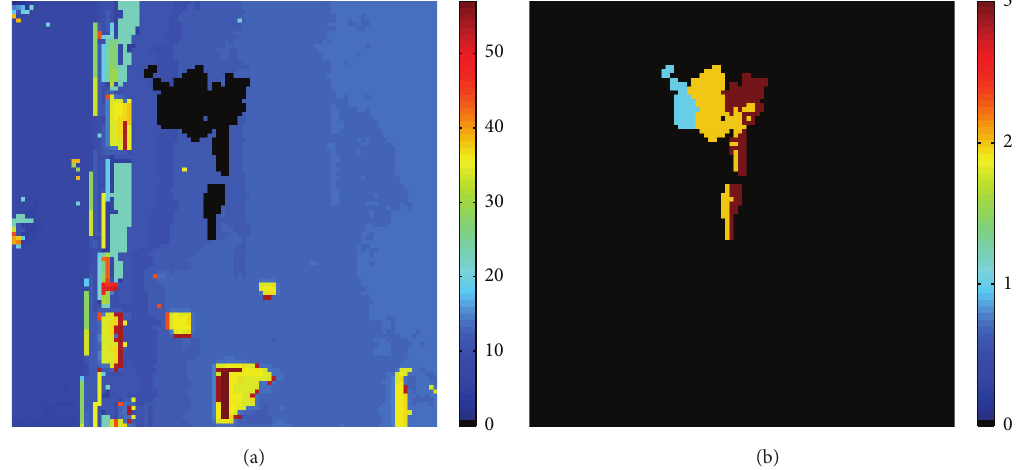
Figure 14: Classification results on Telops parking scene. (a) Plume-absent region. (b) Plume-present